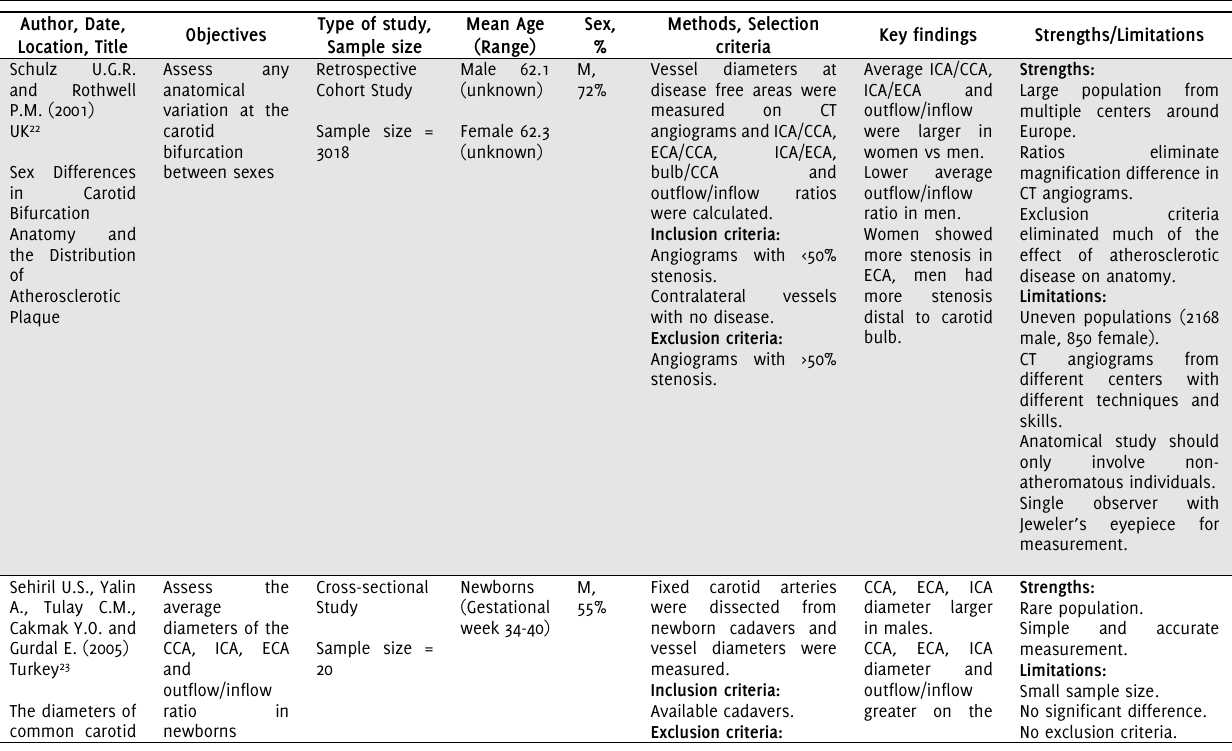
Table 2 . Demographic variations in carotid artery anatomy in patients with and with